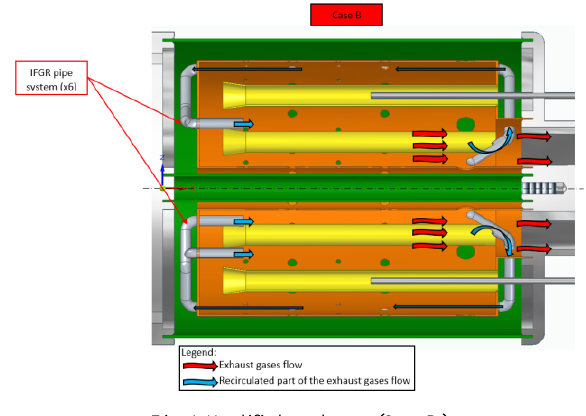
Fig. 6. External view of the computational domain (the external view is similar in all